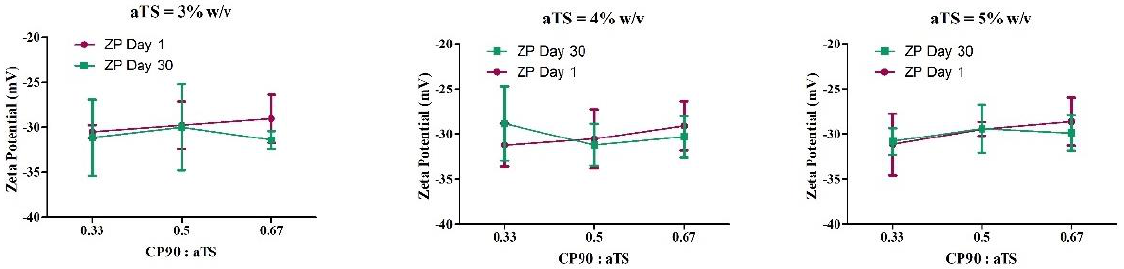
Figure 4. Descriptive plots for the effect of the amount of α TS and CP90: α TS ratio on the zeta potential when the concentration of α TS is 3%, 4% and 5%.